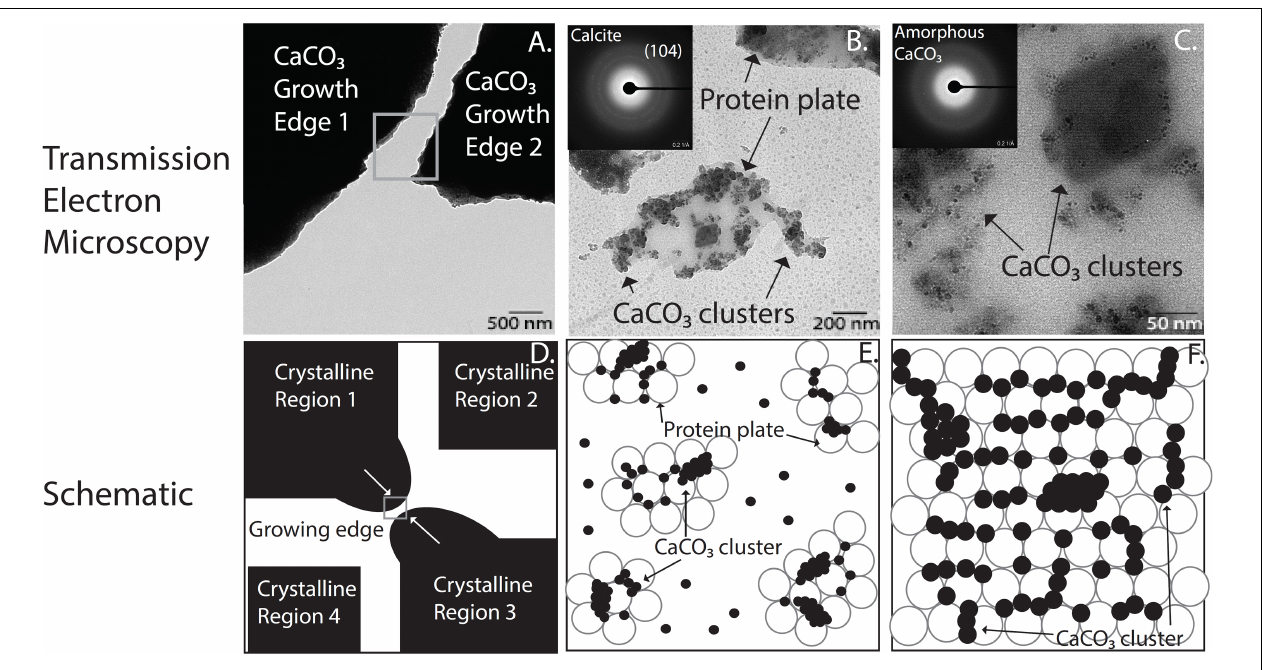
FIGURE 2 | High spatial and temporal arrangement of organic and mineral islands of CaCO 3 intermediate phases of crystallization found in the developing sea urchin larval spine. (A–C) Transmission electron micrographs (TEM) of CaCO 3 remineralized proteinaceous scaffolds from sea urchin spine at increasing magnification insets in panels (B,C) show diffraction patterns of crystalline and amorphous regions, respectively. (D–F) A schematic diagram demonstrates a biphasic behavior found in protein mediated biological CaCO 3 mineralization systems among the organic and mineral components. Subsequent panels are corresponding higher magnification zoom-ins of the previous